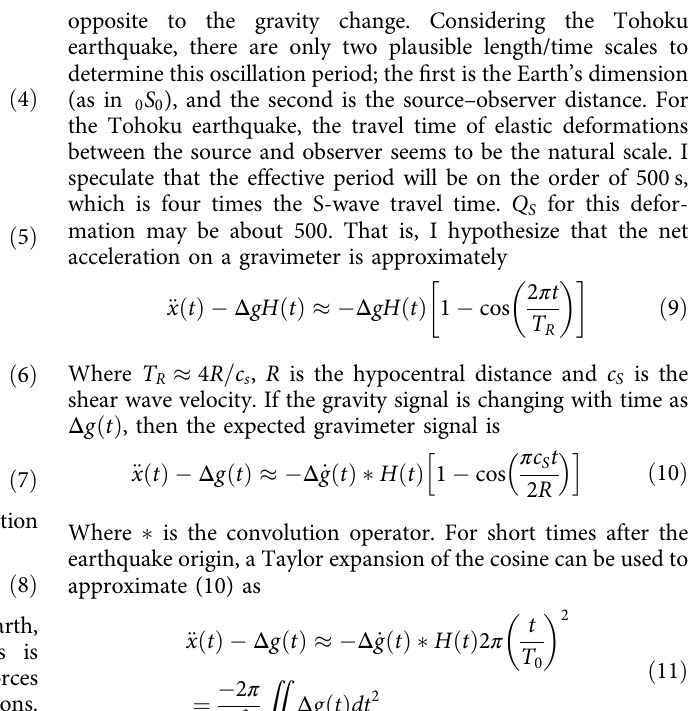
Therefore, the expected gravimeter signal for the Tohoku earthquake that is shown in Fig. 4a of Montagner et al. 1 , should